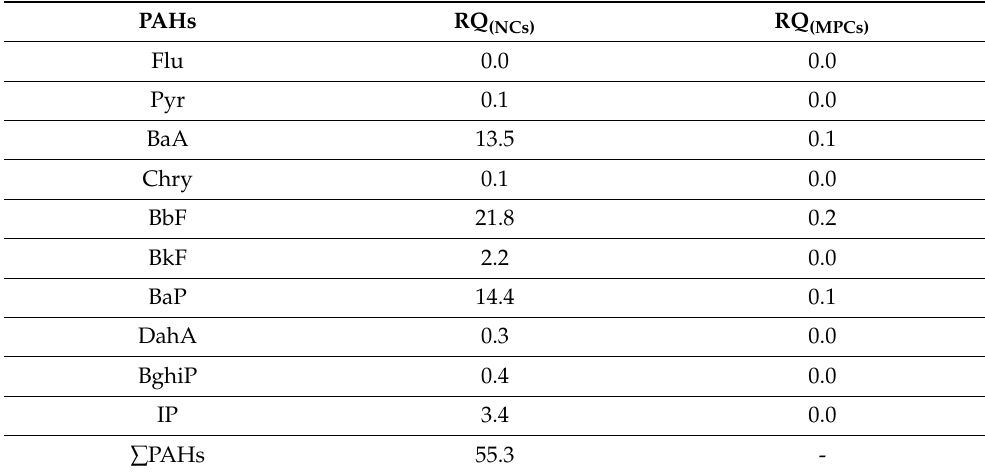
Table 5. Calculated median values of RQ (NCs) and RQ (MPCs) for individual toxic PAHs and ∑ PAHs in bulk deposition. PAHs RQ (NCs) RQ